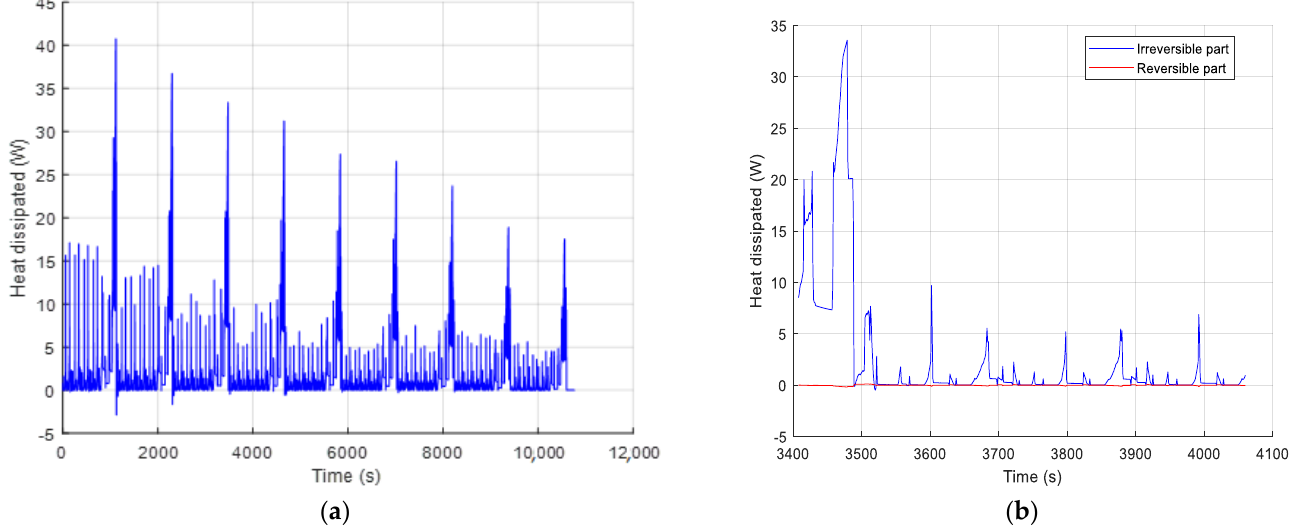
Figure 18. Heat generation predicted with Bernardi model: ( a ) Total heat, ( b ) Reversible and irreversible parts.